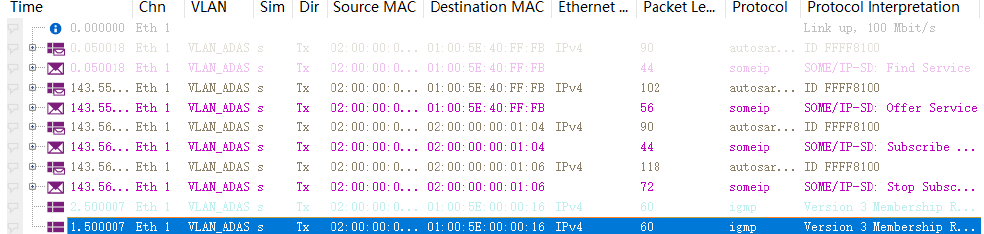
Figure 16. Trace communication data graph.